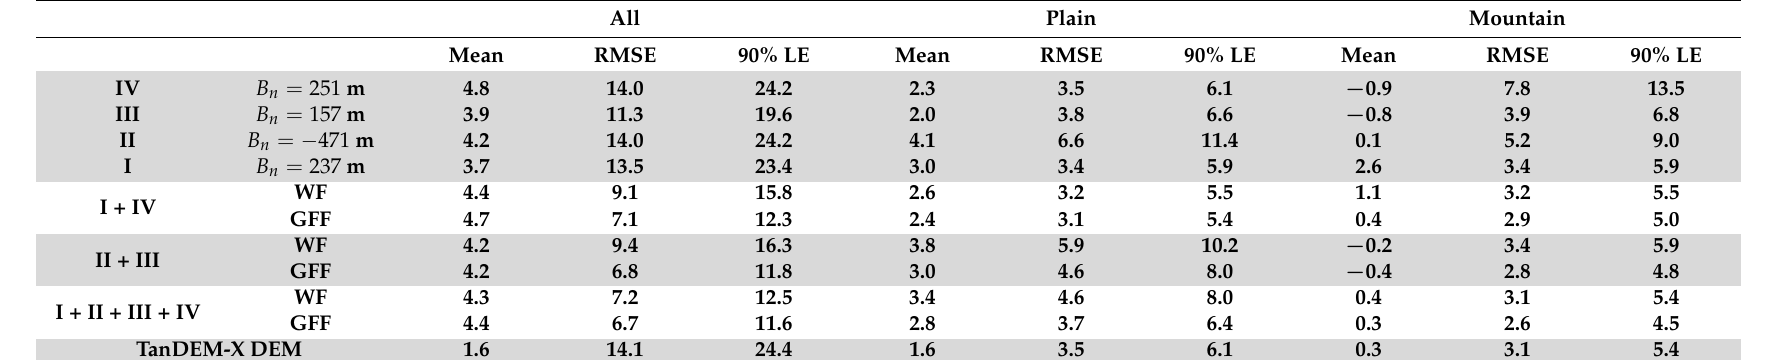
Table 2. Statistical values of height errors with respect to the photogrammetric digital elevation model (DEM) (unit: m). All Plain Mountain